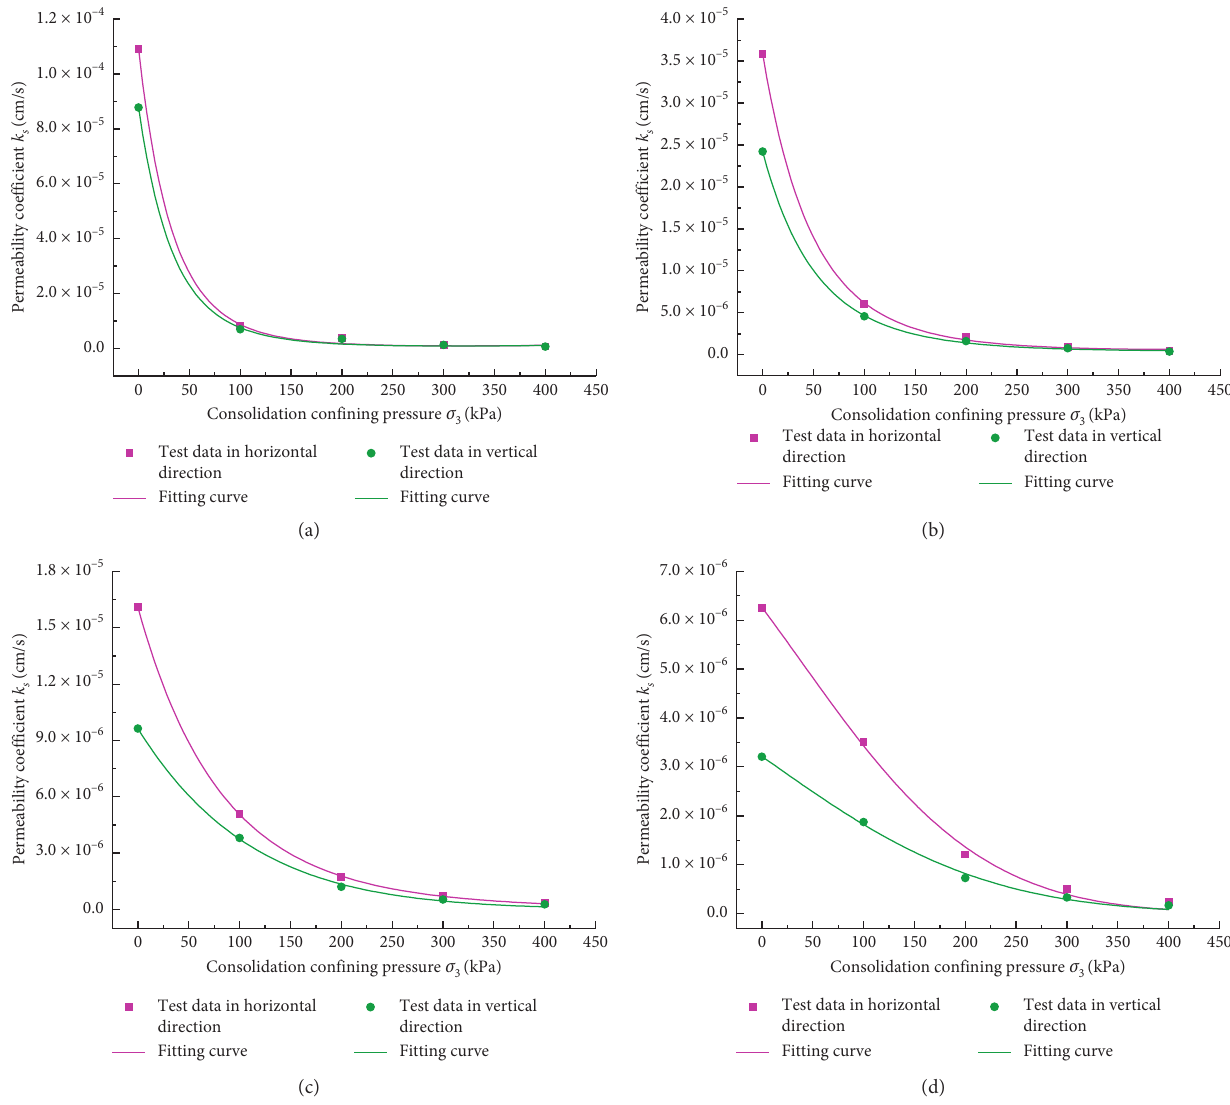
Figure 7: Relationship between the saturated permeability coefficient and the consolidation confining pressure. (a) Initial dry density